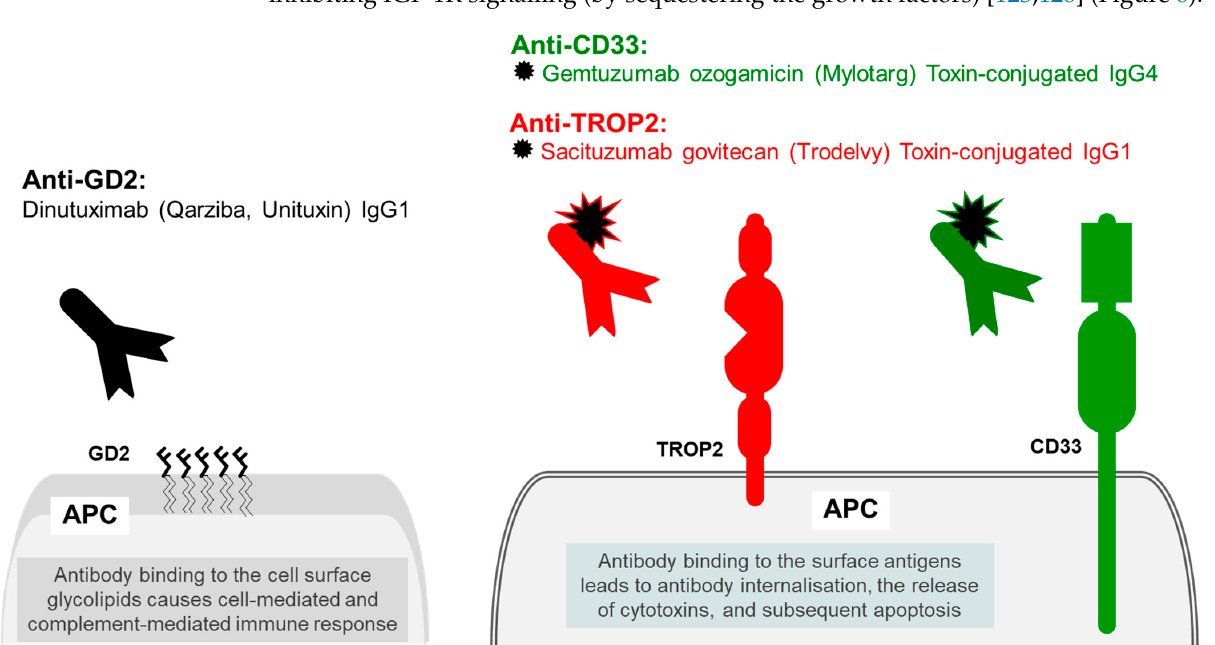
Figure 6. Other cancer targets. Epithelial antigen TROP2 is targeted with monoclonal antibody conjugated to topoisomerase inhibitor SN-38. Myeloid cell surface antigen CD33 is targeted with monoclonal antibody conjugated to a cytotoxic antibiotic N-acetyl gamma calicheamicin. Unconjugated monoclonal antibody targeting of tumour-specific disialoganglioside.